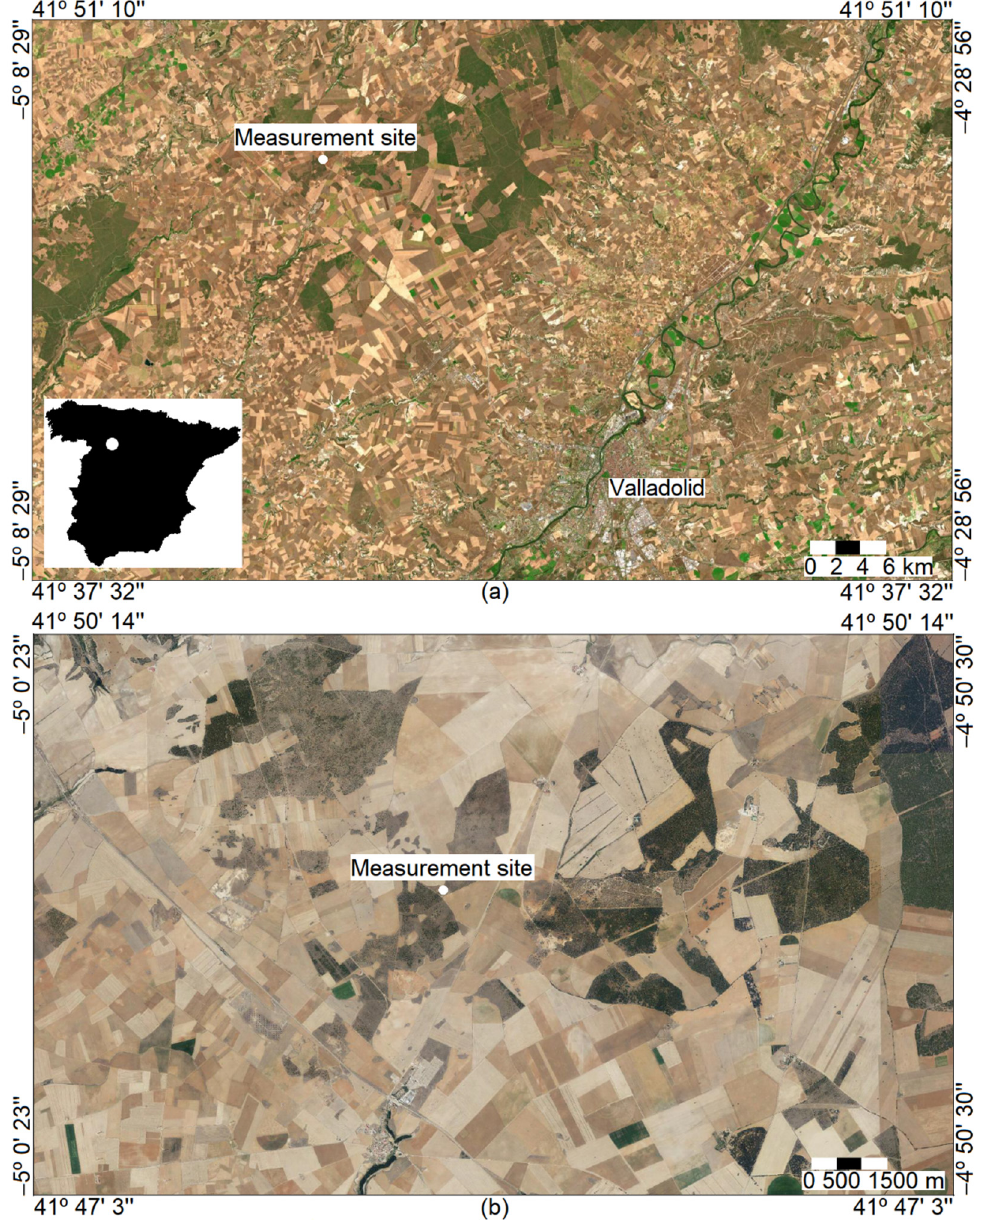
Figure 1. ( a ) Location of the measurement site and the main urban site, Valladolid. Bottom left is the location of the measurement site in Spain. ( b ) Surrounding area of the measurement site, formed mainly by crops. Images courtesy of © ign.es.